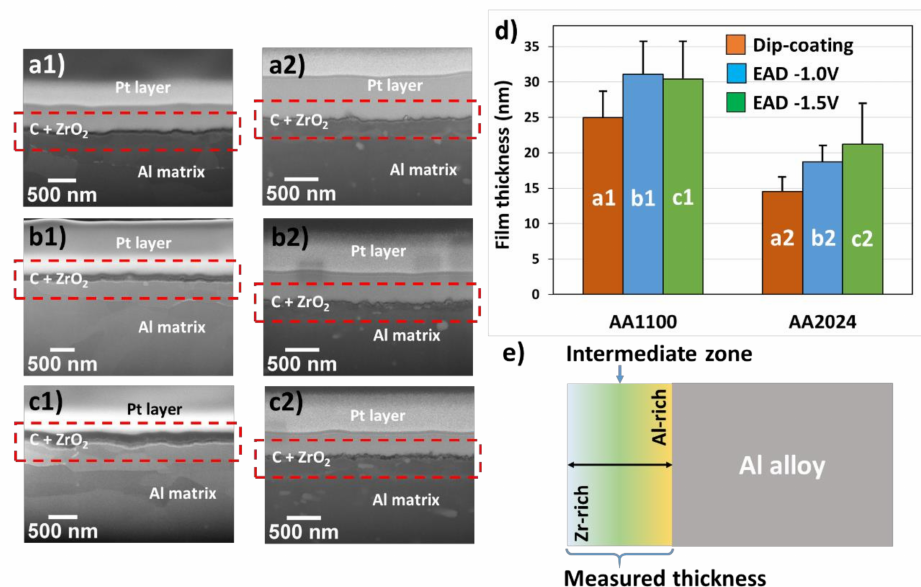
Figure 2. ( a – c ) Cross-section of FIB-SEM micrographs showing the ZrO 2 film thickness between Pt layer and metal substrate, previously degreased with alkaline solution (Bare). ( d ) Values of thicknesses and deviations of samples AA1100 and AA2024, evaluated by HR-SEM. ( e ) Schematic representation of ZrO 2 layer over Al alloy surfaces. Letter codification: ( a ) Dip-coating method; ( b ) Zr-EAD at − 1.0 V; ( c ) Zr-EAD at − 1.5 V; and number codification: (1) AA1100 and (2) AA2024 plates. SEM magnifications: (a1) 81.81 kX; (a2) 100 kX; (b1) 72.43 kX; (b2) 100 kX; (c1) 85.28 kX; and (c2) 100 kX. Red rectangles indicate the region used for the thicknesses measurements. The different layers can be easily discriminated in the Figure S2 (supporting information), and are composed by: Pt, carbon graphite and Zr-DC or Zr-EAD